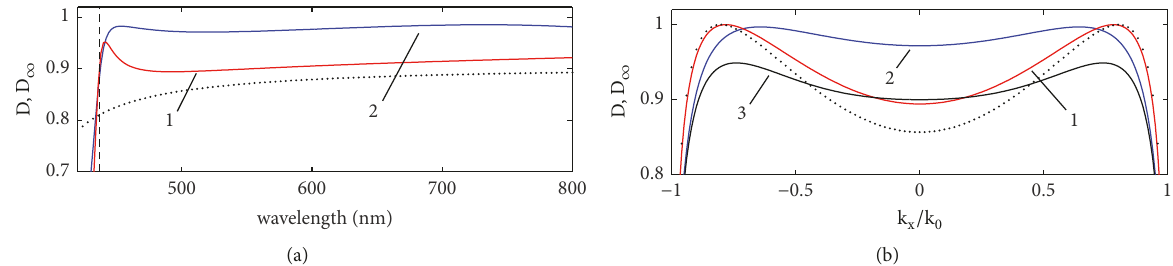
Figure 5: (Color online) the absorption coefficient 𝐷 of the nonuniform metamaterial film as a function of the (a) wavelength (at normal incidence) and (b) tangential wavevector component of the incident light ( 𝜆 = 500 nm); the thickness of the film is 𝐿 𝑦 = 200 nm (curve 1), 𝐿 = 100 nm (curve 2), and 𝐿 = 50 nm (curve 3). Dotted line is the absorption coefficient 𝐷 𝑦 𝑦